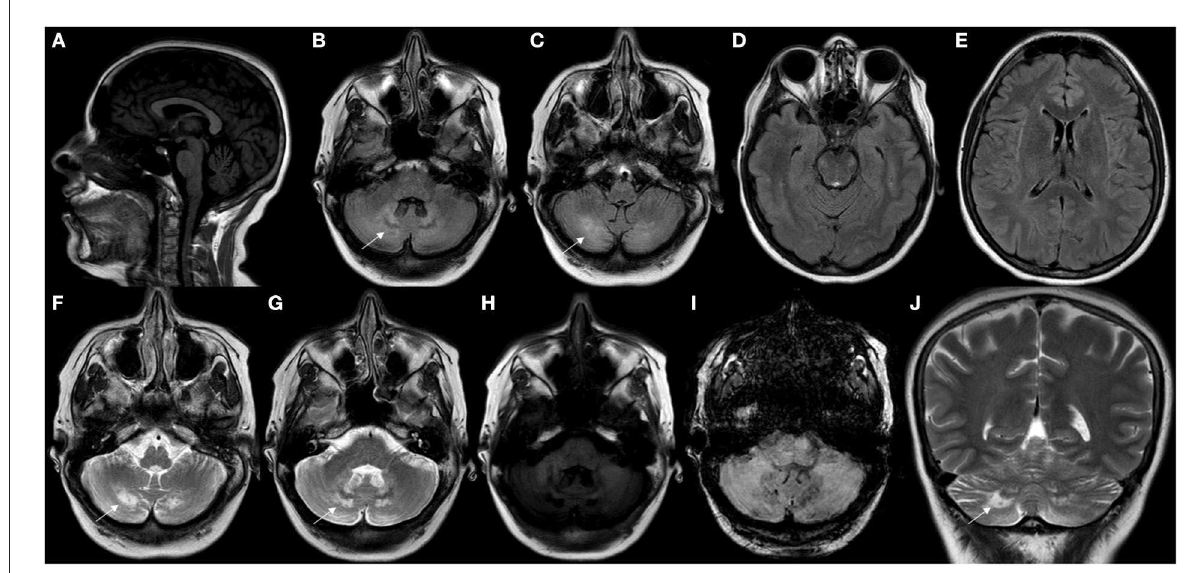
FIGURE4 Neuroimaging findings in CTX. (A) Sagittal T1W brain MR imaging (MRI) disclosed mild cerebellar atrophy. (B–G) Axial brain MRI showed hyperintensity involving cerebellar white matter and dentate nuclei (white arrows) in FLAIR (B–E) and T2W imaging (F, G) . Axial brain MRI showing mild hypointensity involving cerebellar white matter and dentate nuclei in T1W (H) and SWI sequences (I) . Coronal brain MRI showing hyperintensity (white arrow) involving cerebellar white matter and dentate nuclei in T2W imaging (J)